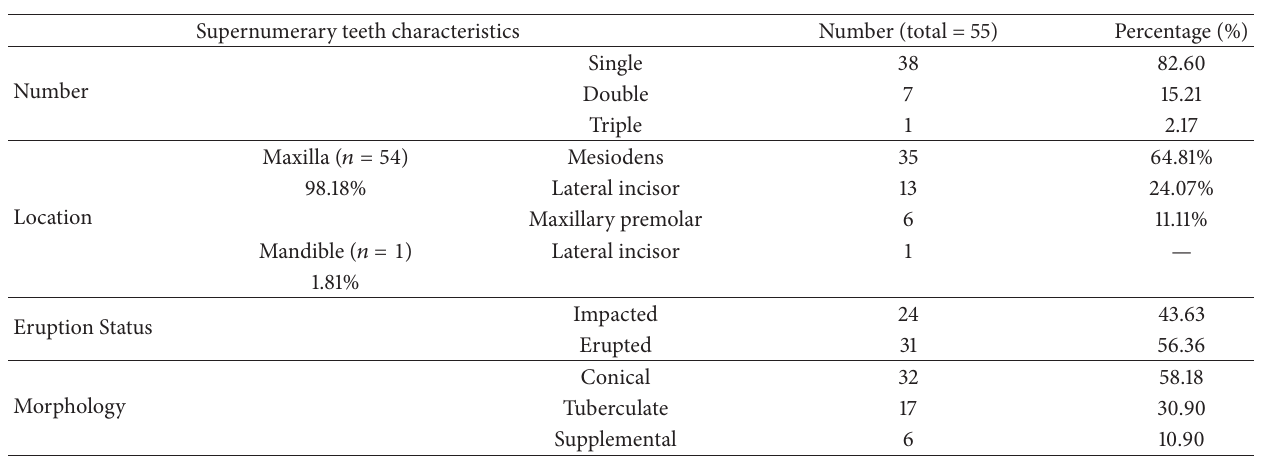
Table 2: Summary of the characteristics of supernumerary teeth.